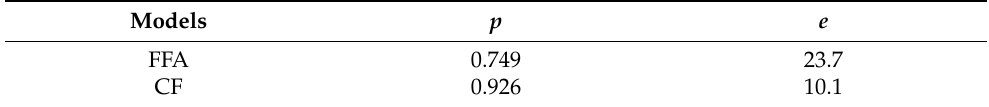
Table 4. Comparison results of different models.